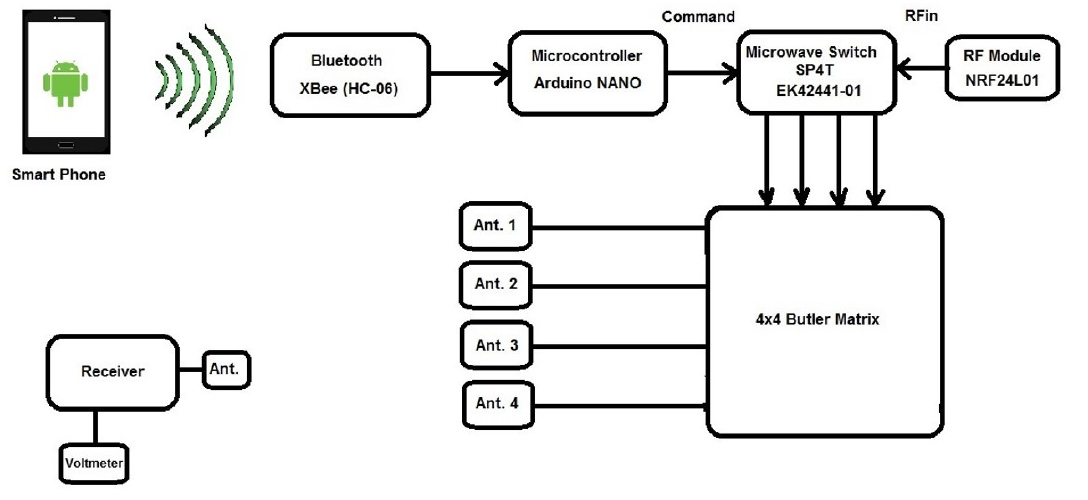
Figure 4. Block diagram for the intelligent wireless power transfer.